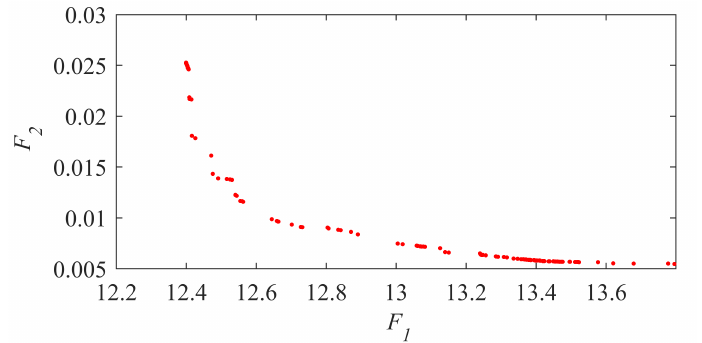
Figure 7. IEEE 14 bus test system: a multiobjective approach based on Pareto optimal solutions.